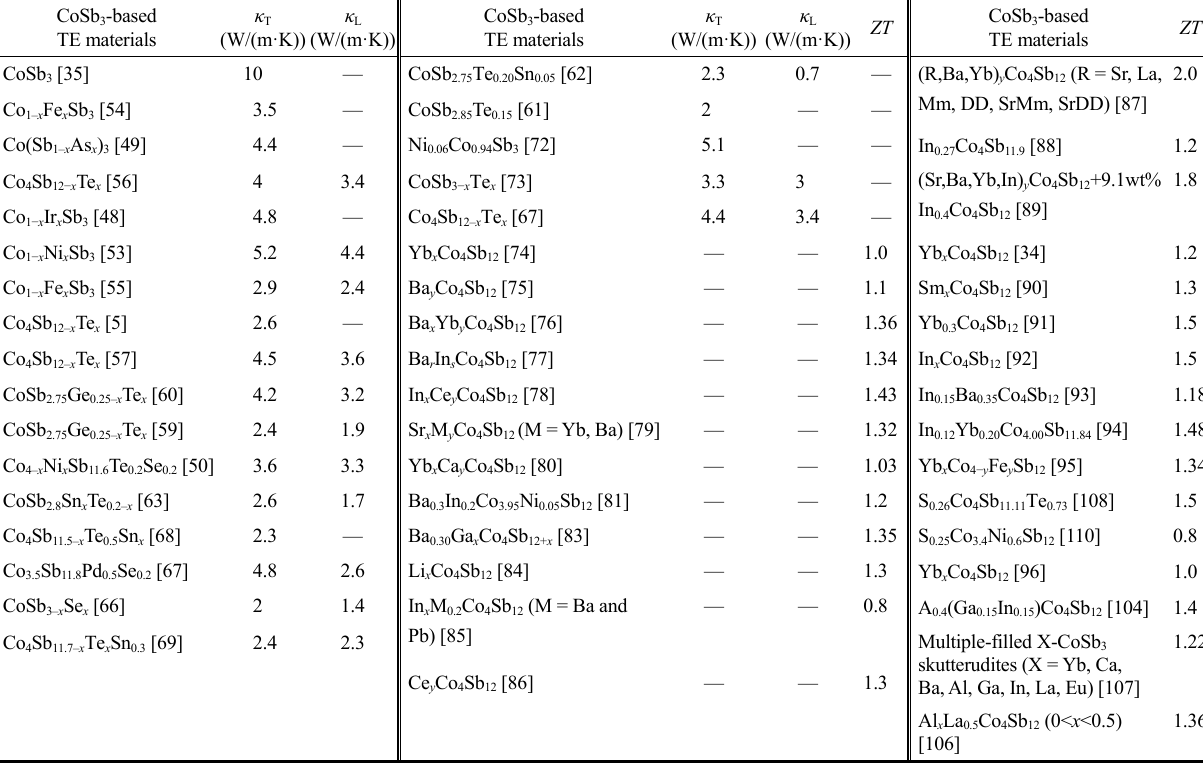
Room-temperature thermal conductivity ( κ T ) and lattice thermal conductivity ( κ L ) of several typical CoSb 3 -based solid solution alloy materials, and ZT values of several typical CoSb 3 -based filled skutterudites TE materials CoSb 3 -based TE